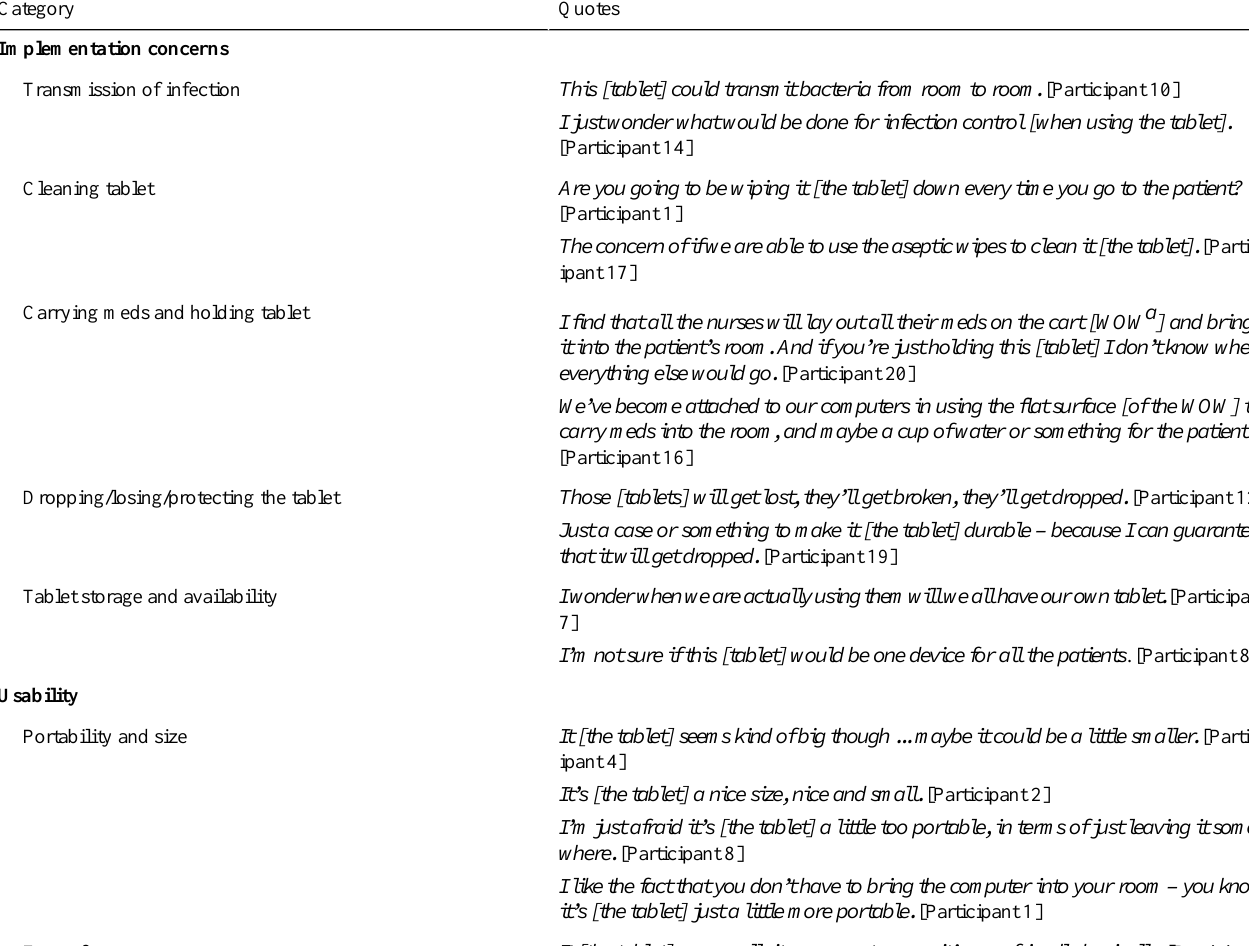
Table 5. Summary feedback on the prototype near field communication-enabled medication administration (NFCMA) system by category with example participant